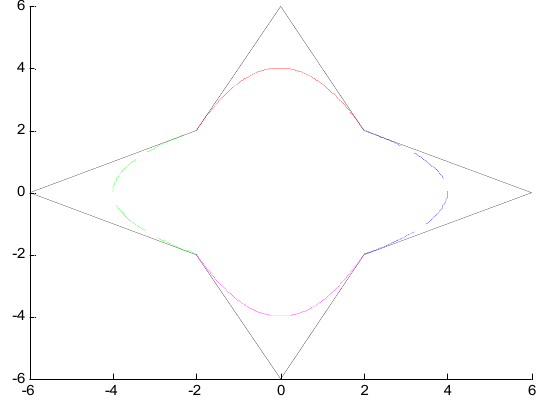
Figure 1. G 0 (also C 0 ) smooth continuity of quadratic S- λ curves.